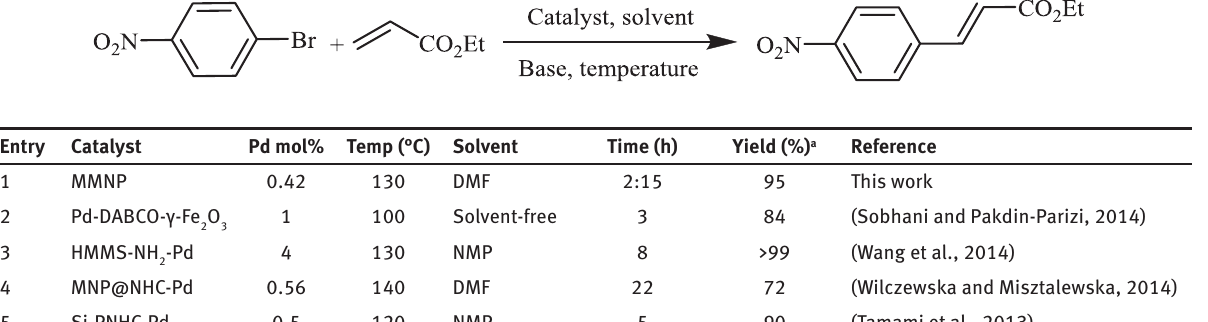
Table 7: The comparative study of MMNP catalytic activity with other catalyst in Heck reaction.